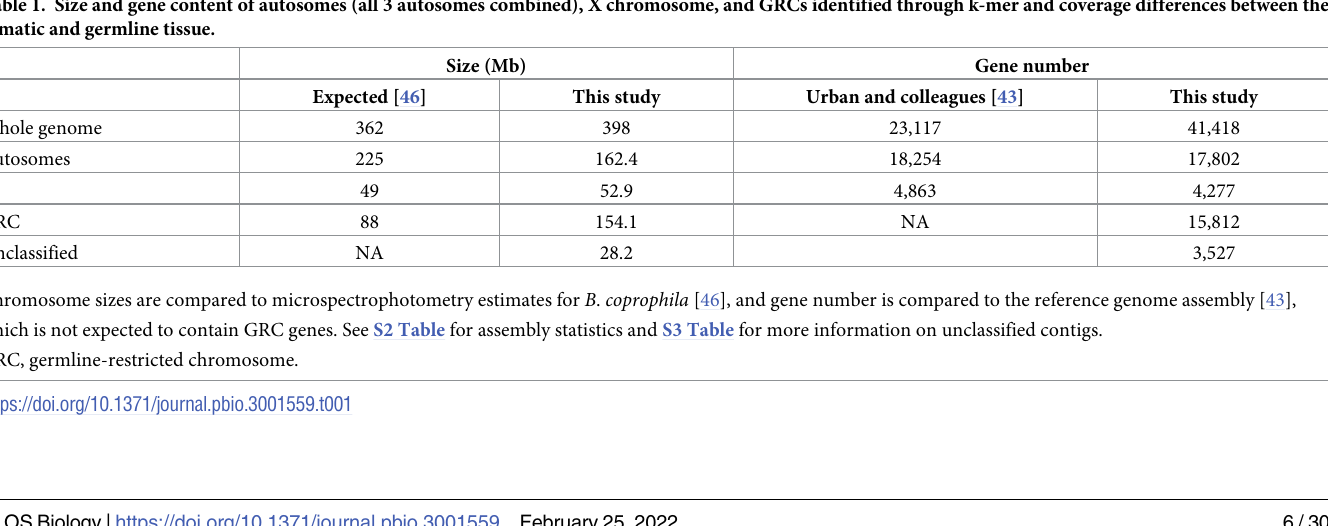
Table 1. Size and gene content of autosomes (all 3 autosomes combined), X chromosome, and GRCs identified through k-mer and coverage differences between the somatic and germline tissue.